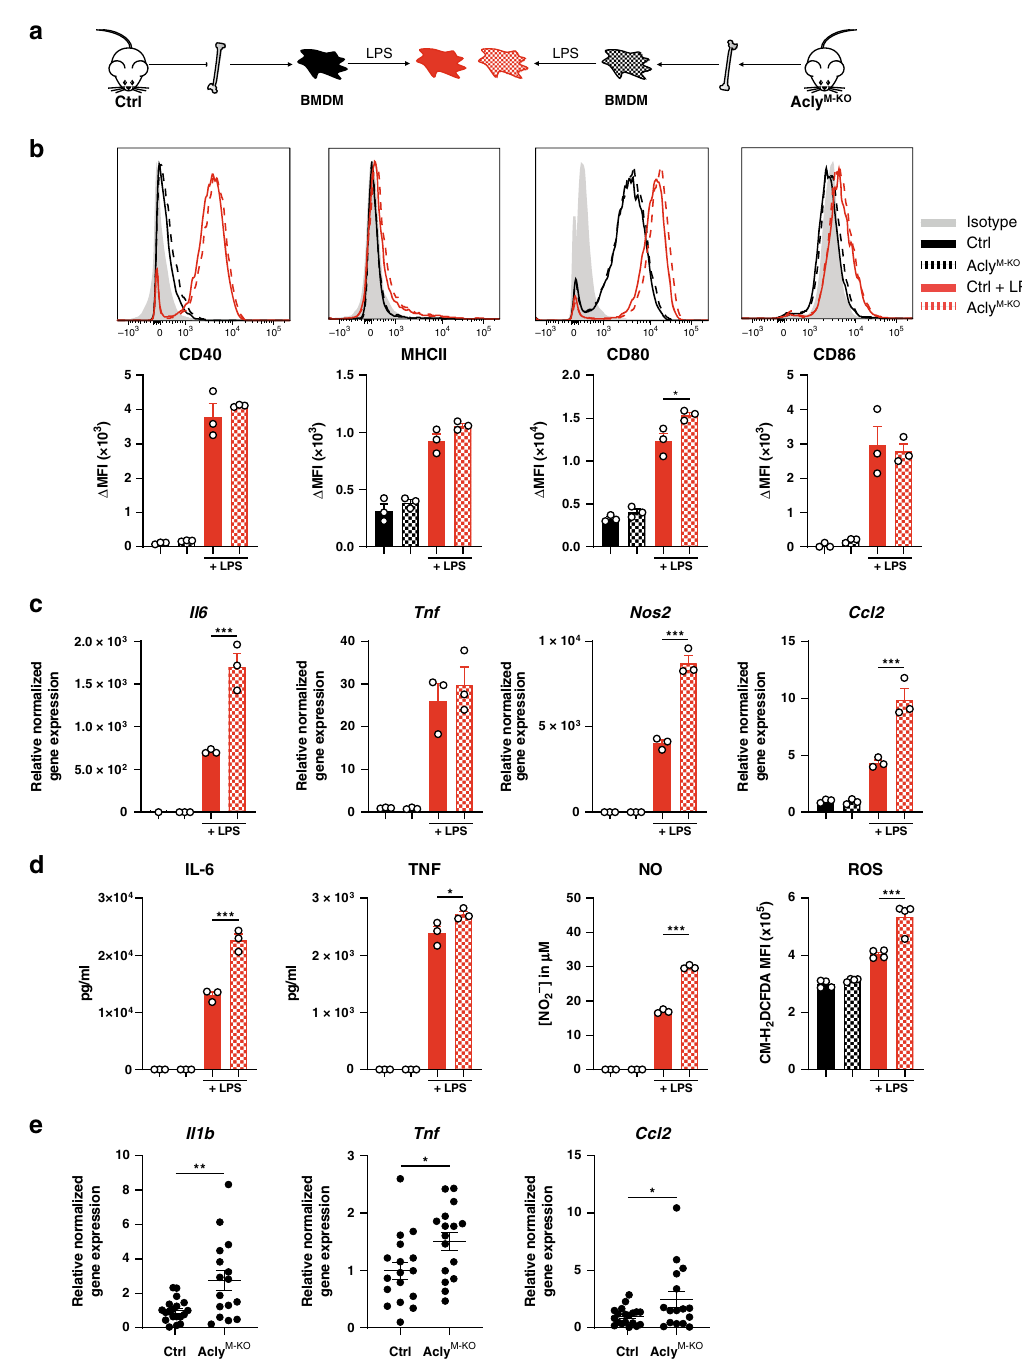
Fig. 3 Altered macrophage polarization in vitro does not explain the plaque phenotype in vivo. a Differentiated control and Acly M-KO macrophages (BMDMs) were stimulated with LPS. b Expression of LPS-induced surface markers as measured by fl ow cytometry. Representative histograms and quanti fi ed surface expression ( Δ MFI = [median fl uorescence intensity] positive staining – [MFI] pooled control ) are shown. CD80 * P = 0.0160. c Relative normalized gene expression of indicated LPS-induced genes. Il6 *** P < 0.0001, Nos2 *** P < 0.0001, Ccl2 *** P = 0.0002. d Production of IL-6 *** P < 0.0001, TNF * P = 0.0281, NO *** P < 0.0001 and ROS *** P < 0.0001. e Normalized expression of M1 genes in aortic arches of control and Acly M-KO -transplanted mice. Il1b ** P = 0.0030, Tnf *P = 0.0183, Ccl2 * P = 0.0321. Values represent mean±SEM of n = 3 ( b – d ) technical replicates of one out of three representative experiments or n = 20/17 (ctrl/KO in e ). *P < 0.05; **P < 0.01, ***P < 0.001 by ordinary one-way ANOVA with Bonferroni post hoc test for multiple comparisons ( b – d ) or two-tailed Student ’ s t test ( e ). Source data are provided as a Source Data fi le ( b – e